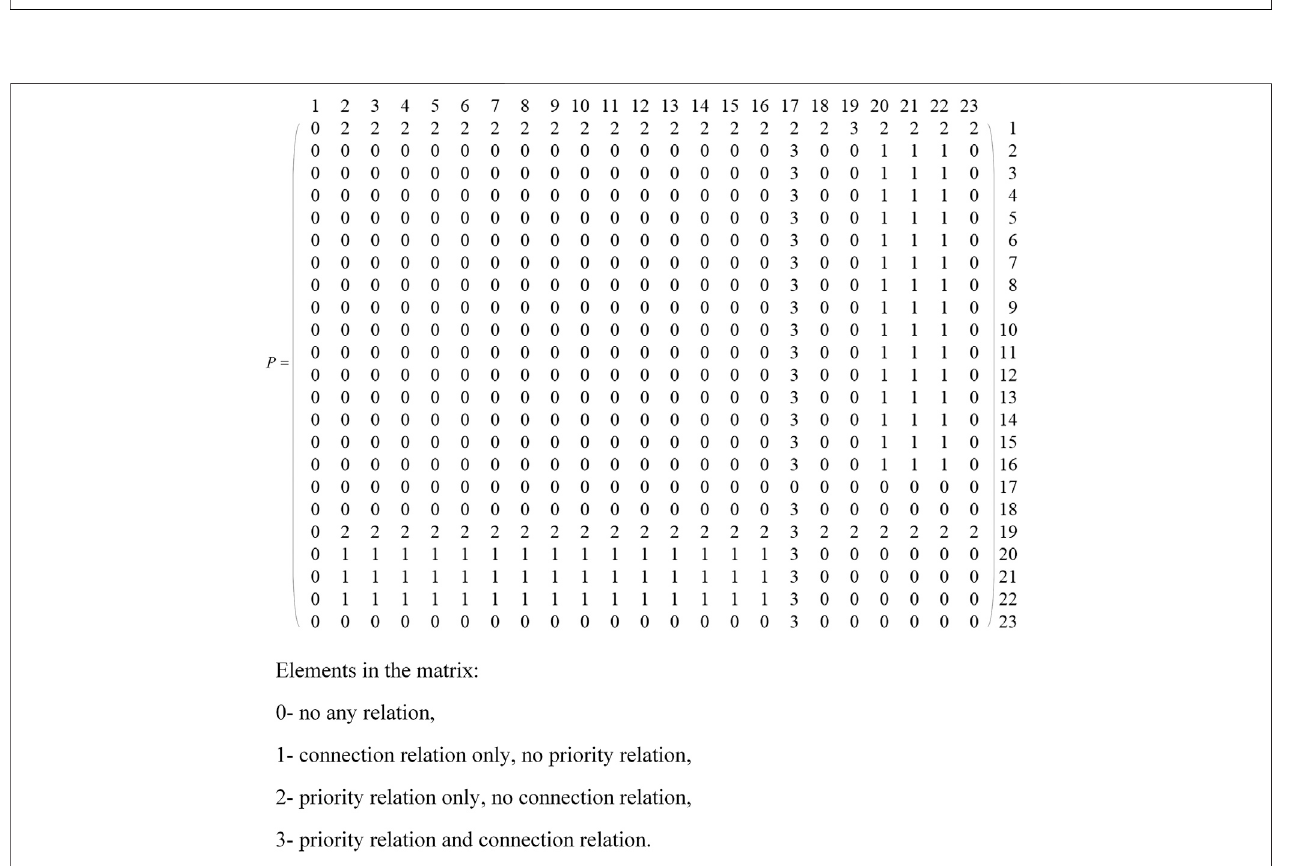
FIGURE 8 | Disassembly relationship hybrid graph of components in the EVB.